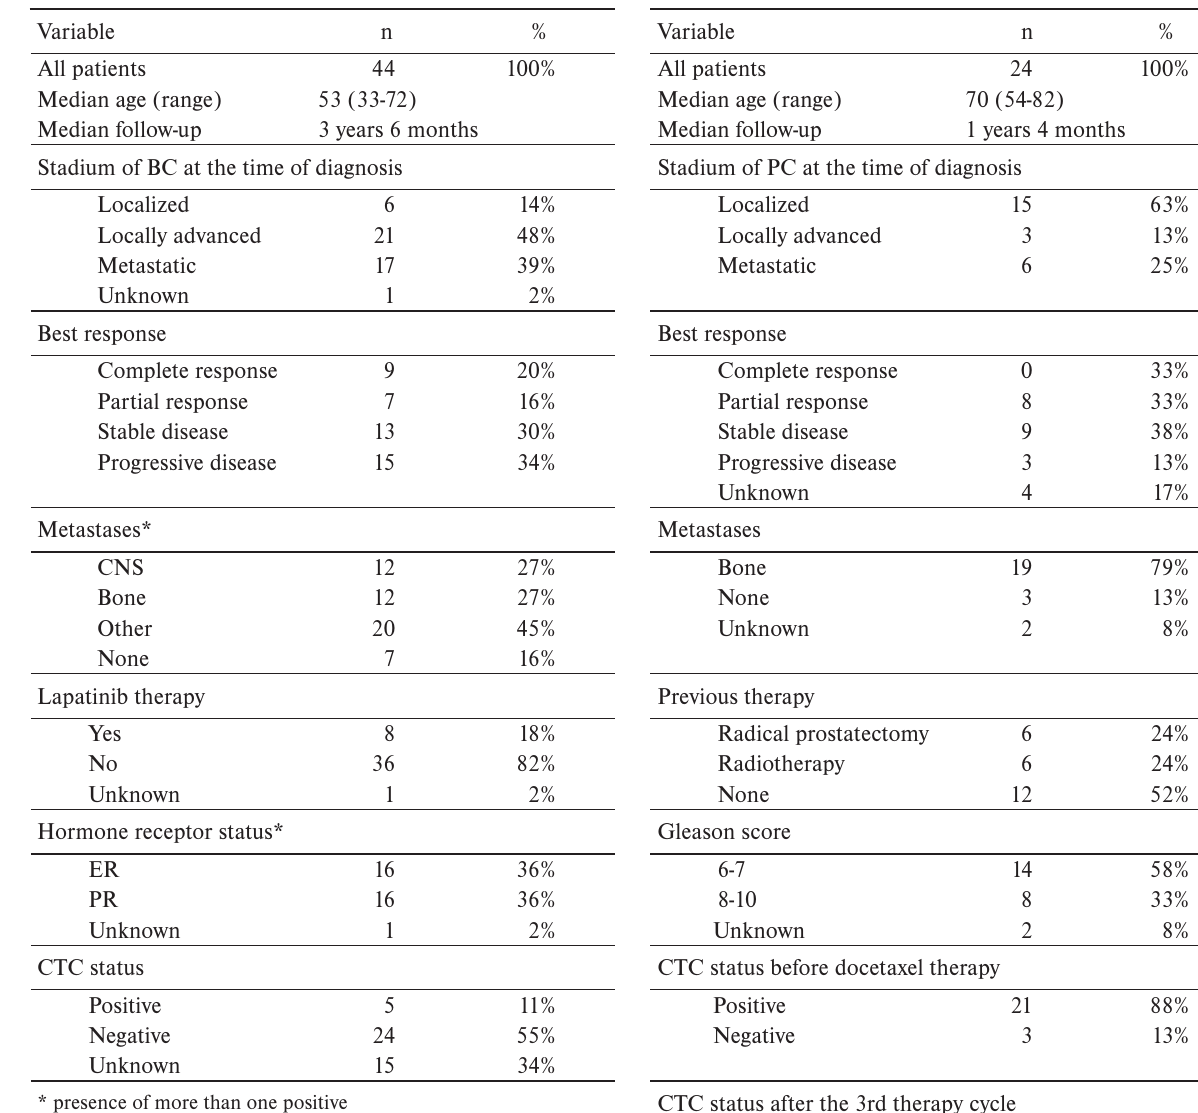
Table 1. Study group